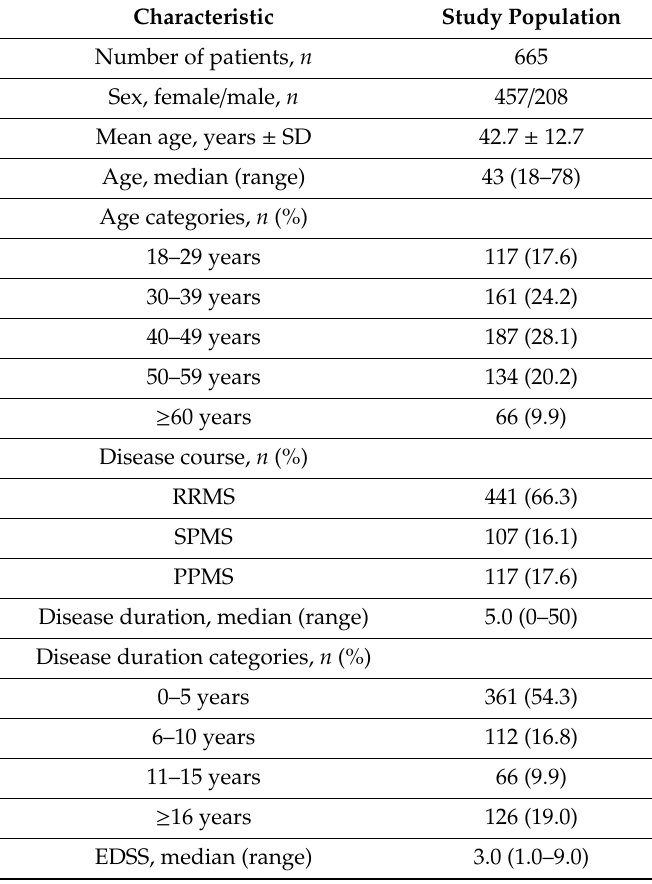
Table 1. Clinical and demographic characteristic of multiple sclerosis (MS) patients at the time of the STRATIFY John Cunningham virus (JCV) DxSelect